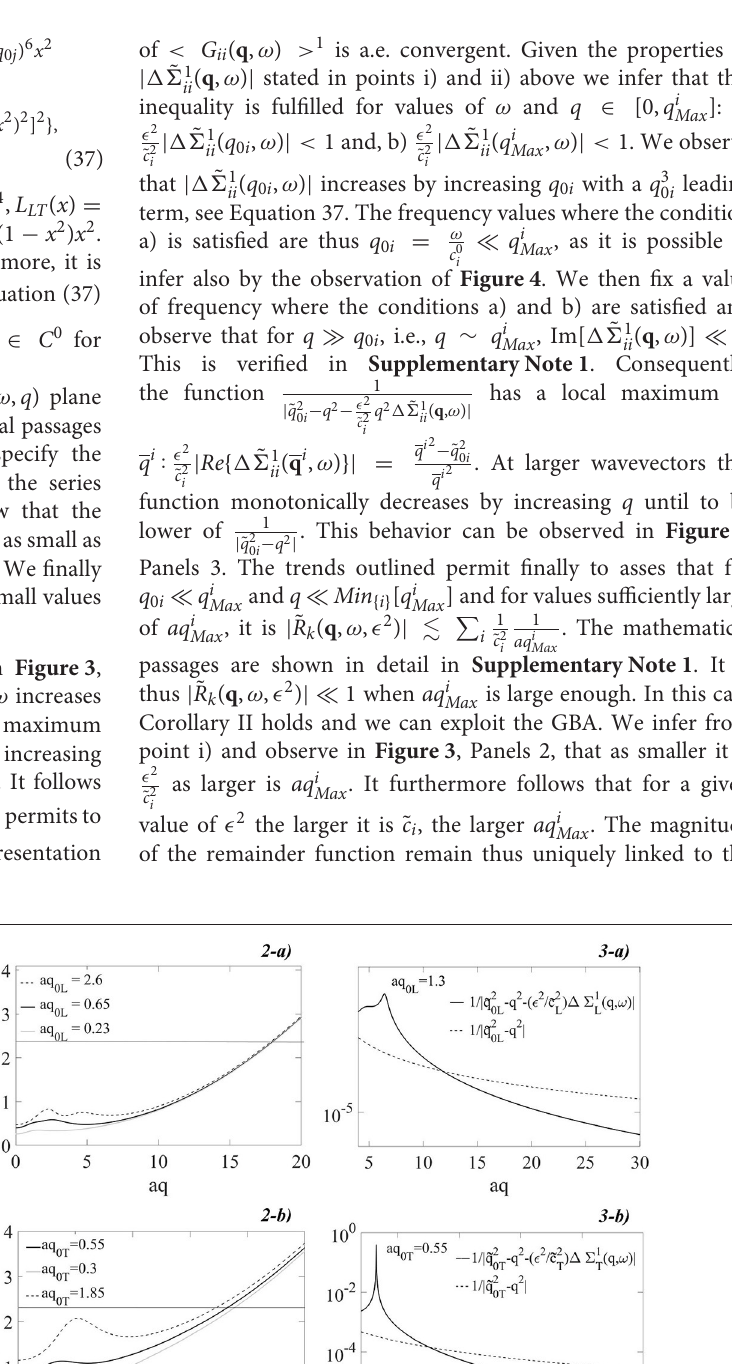
2 0 | 1 ˜ 6 1 T ( q , ω ) | . (2) µ ˜ c 2 T